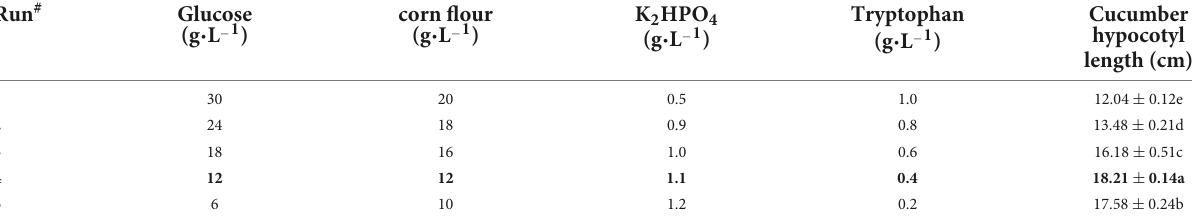
TABLE 2 Steep climbing test design and